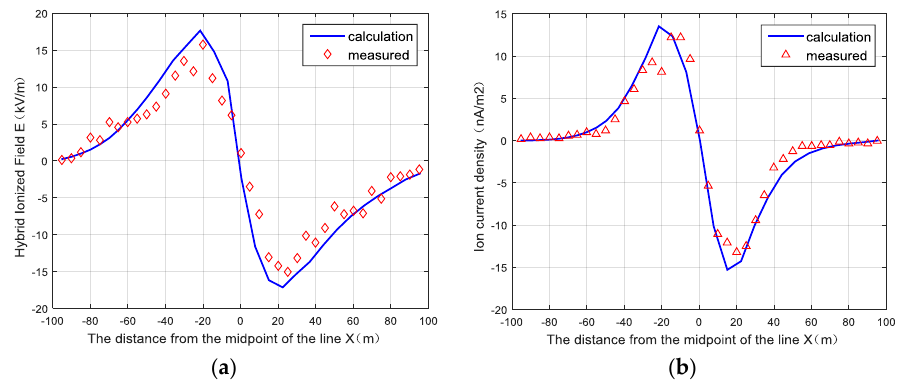
Figure 8. Comparison of calculation and measurement. ( a ) Hybrid ionized field. ( b ) Ion current density.